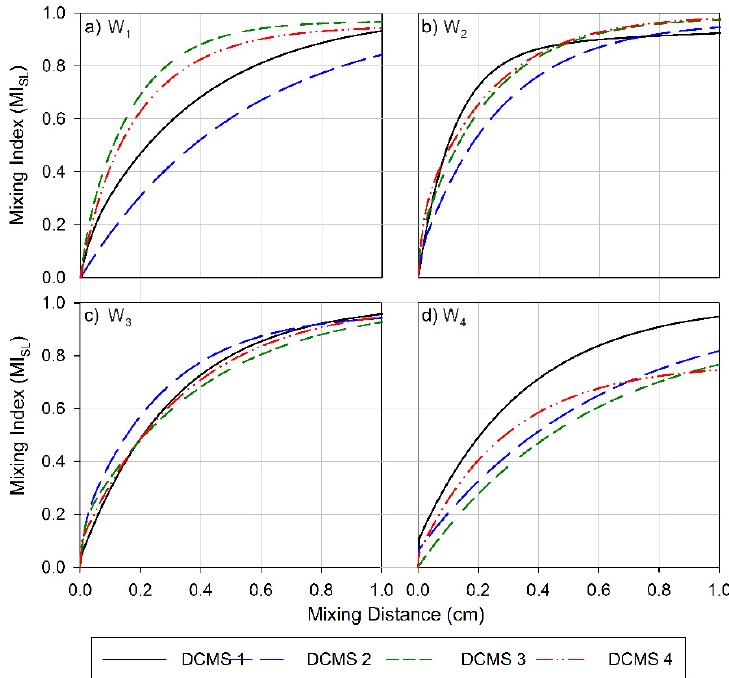
Figure A2. Mixing index at the surface layer versus the channel length for ( a ) Wafer 1, ( b ) Wafer 2, ( c ) Wafer 3 and ( d ) Wafer 4. Data obtained for channels with parameter design variables (PDV, Table 1) are depicted as follow: PDV 1 is a black solid line, PDV 2 is a blue long-dashed line, PDV 3 is a green three short-dashed line and PDV 4 is a red dashed-dot-dot line. Table A1. Range in MI found at the outlet (1 cm) and the mixing distance (MD) required to obtain a mixing index of 0.6. The max and min values (and which design these represent) are presented for the channel layers (CL) and the surface layer (SL), as well as the range. Represented are the two design families compared in this article, CMS and DCMS, as well as a previously studied herringbone-type structure (HBS) presented in our previous article [56].